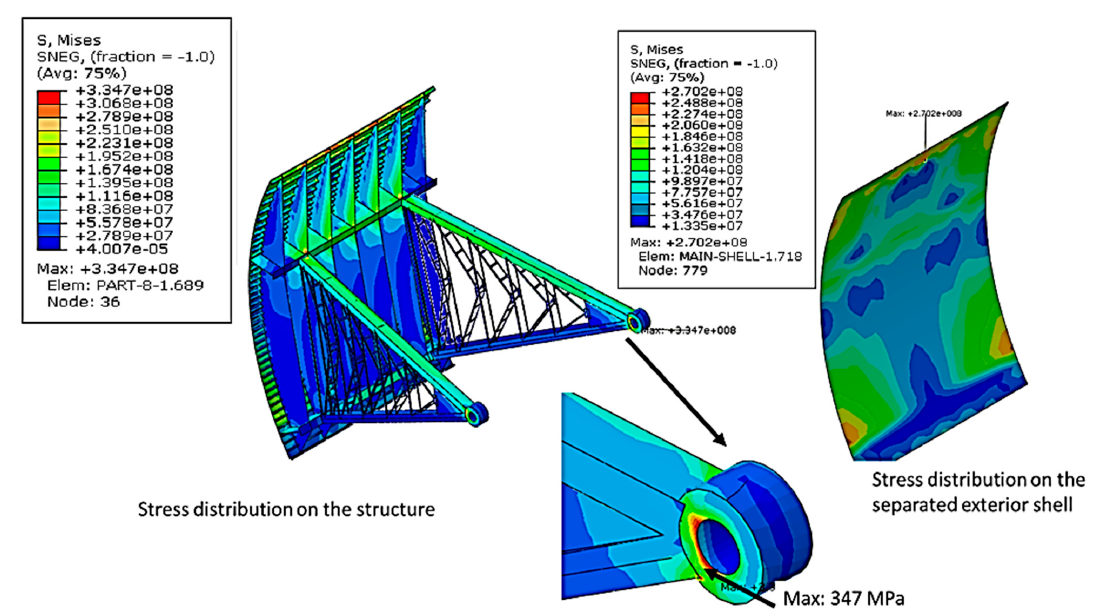
Figure 10. Stress distribution as a result of the shock wave (MCL earthquake).